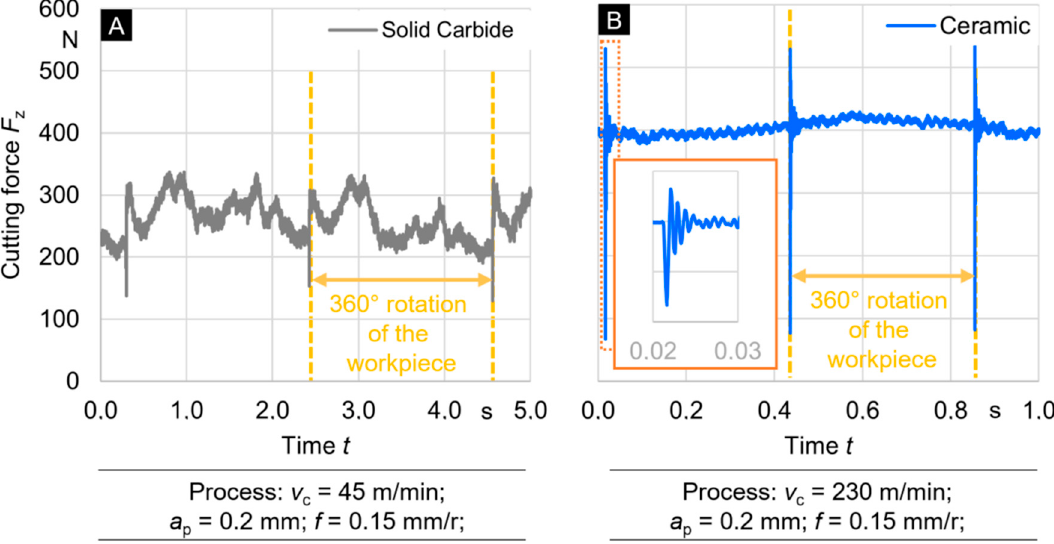
Figure 6. Cutting force measured in z-direction using tools of cemented carbide ( A ) and ceramic ( B ).